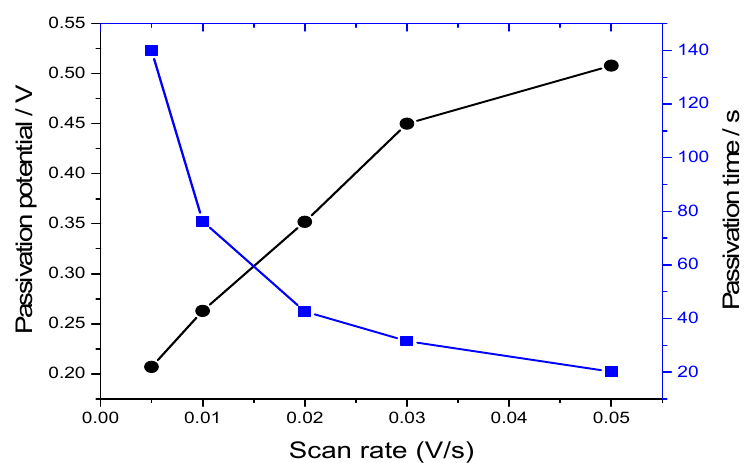
Figure 6. The influence of sweep rate on the equilibrium passivation potential; square-dotted and circle-dotted lines correspond to passivation time and passivation potential, respectively.